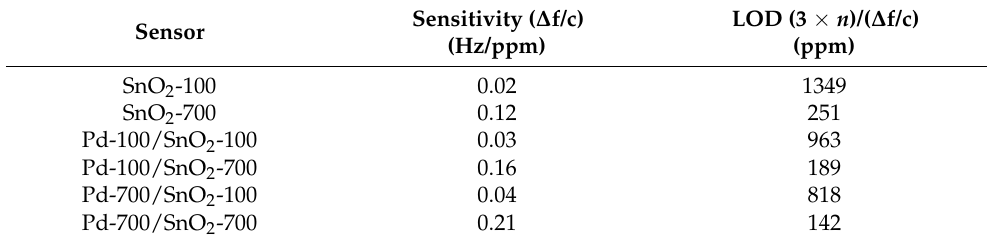
Table 2. Sensitivity and limit of detection (LOD) of the sensors ( Δ f-frequency change; c-hydrogen concentration, n-noise level).